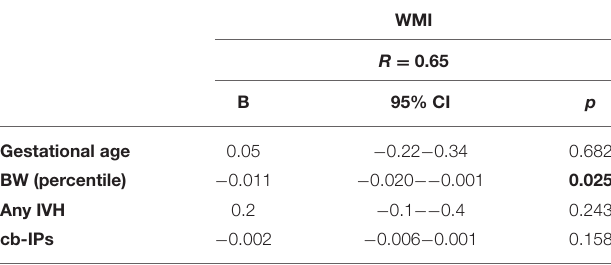
TABLE 2 | Multivariable linear regression analysis between cb-IPs and WMI score at TEA.